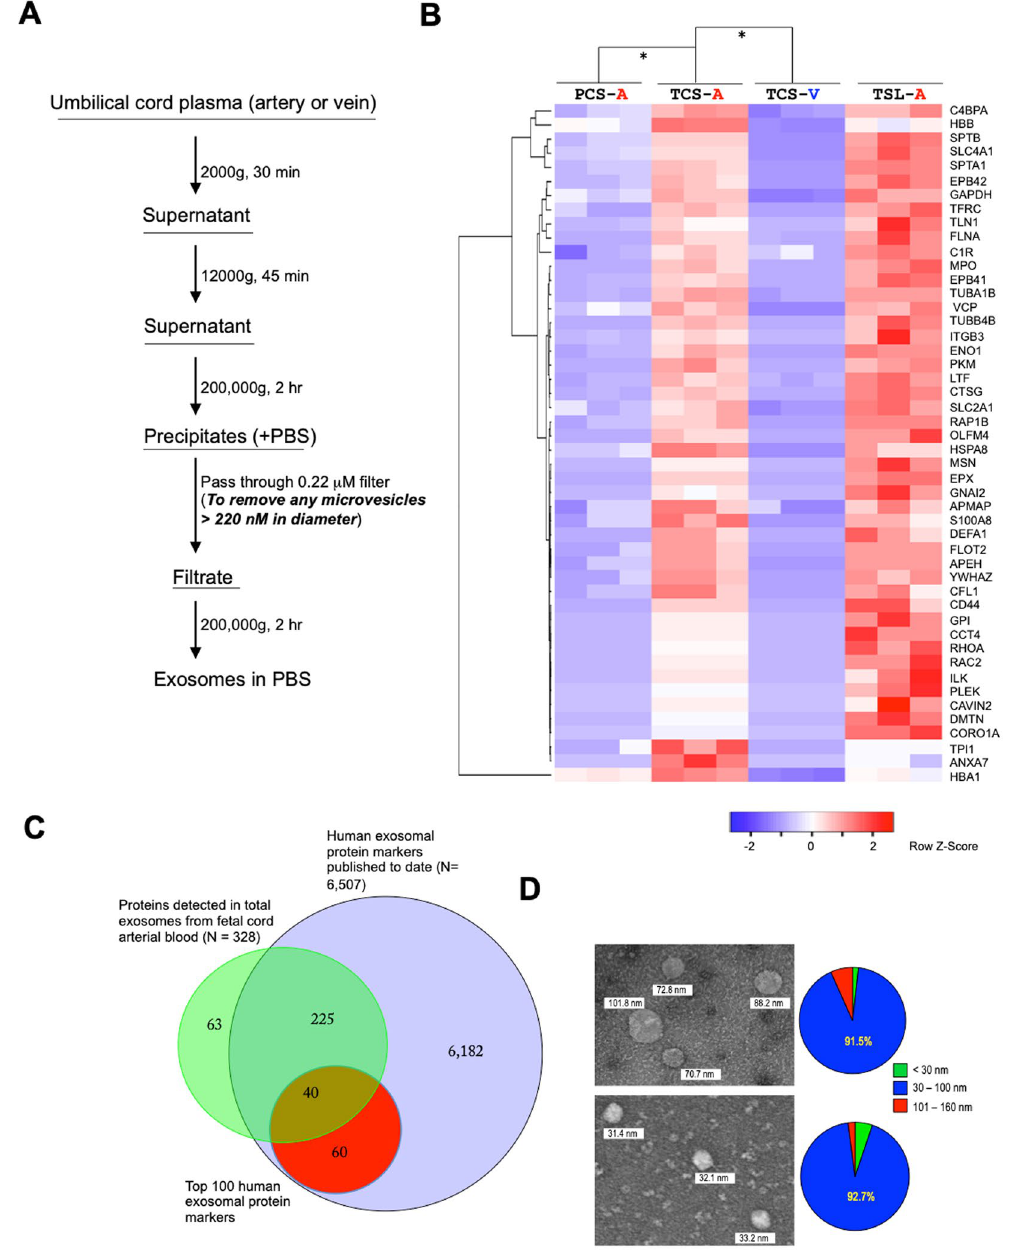
Figure 1. Proteomics analysis of fetal cord blood exosomes. ( A ) Isolation procedure of fetal cord blood exosomes. ( B ) The heatmap showing select proteins with significant difference in normalized abundance in fetal exosomes among groups as indicated ( * p < 0.01). PCS-A, arterial blood exosomes isolated from patients of 35 to 36 weeks of EGA following C-section; TCS-A, arterial blood exosomes isolated from patients of 39 to 40 weeks of EGA following C-section; TCS-V, vein blood exosomes isolated from the same patients of 39 to 40 weeks of EGA following C-section; TSL-A, arterial blood exosomes isolated from patients of 39 to 40 weeks of EGA following spontaneous labor and vaginal delivery. The complete proteomics data is shown in Supplementary Table 1. ( C ) Venn diagram showing the number of exosomal proteins identified in this study, which were overlapped with those published to date 11 . Red circle indicates top 100 exosomal protein markers. ( D ) Imaging of exosomes isolated from the cord arterial blood of the groups as indicated by transmission electron microscope (left panels). For each group, the percentage of microvesicles based on the sizes as indicated was calculated from 10 random fields (right panels). Original magnification, X